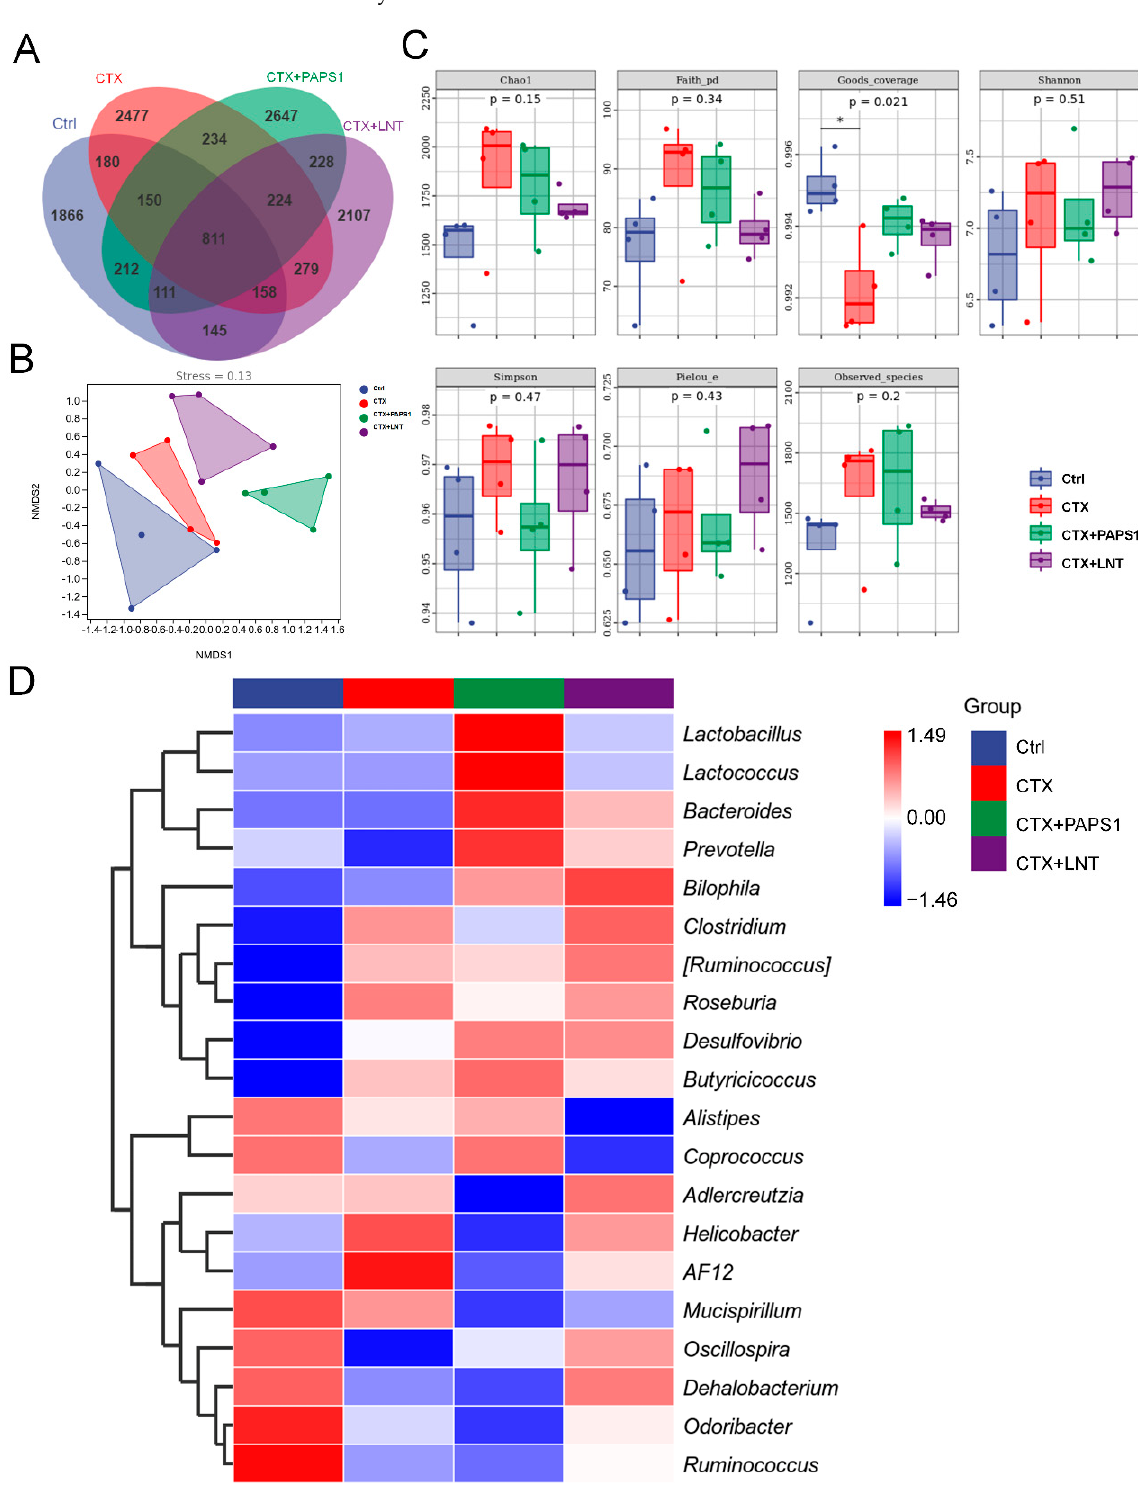
Figure 5. PAPS1 regulated the intestinal microflora of CTX-immunosuppressed mice: ( A ) Venn diagram. ( B ) NMDS of unweighted UniFrac distance from beta diversity analysis. ( C ) Chao1, Faith’s phylogenetic diversity (Faith pd), Good’s coverage, Shannon’s and Simpson’s indices, Pielou’s evenness and the observed species index values from alpha diversity analysis. Data were analyzed using a one-way ANOVA and are expressed as mean ± S.D. ( n = 4). * p < 0.05 compared with Ctrl mice. ( D ) Heatmap of 20 bacterial genera with the most significantly different abundance, calculated from the unweighted UniFrac distance of cecal content samples. NMDS, non-metric multi-dimen- sional scaling. Ctrl, control, CTX, cyclophosphamide; PAPS1, water-soluble PA polysaccharides, LNT, lentinan.